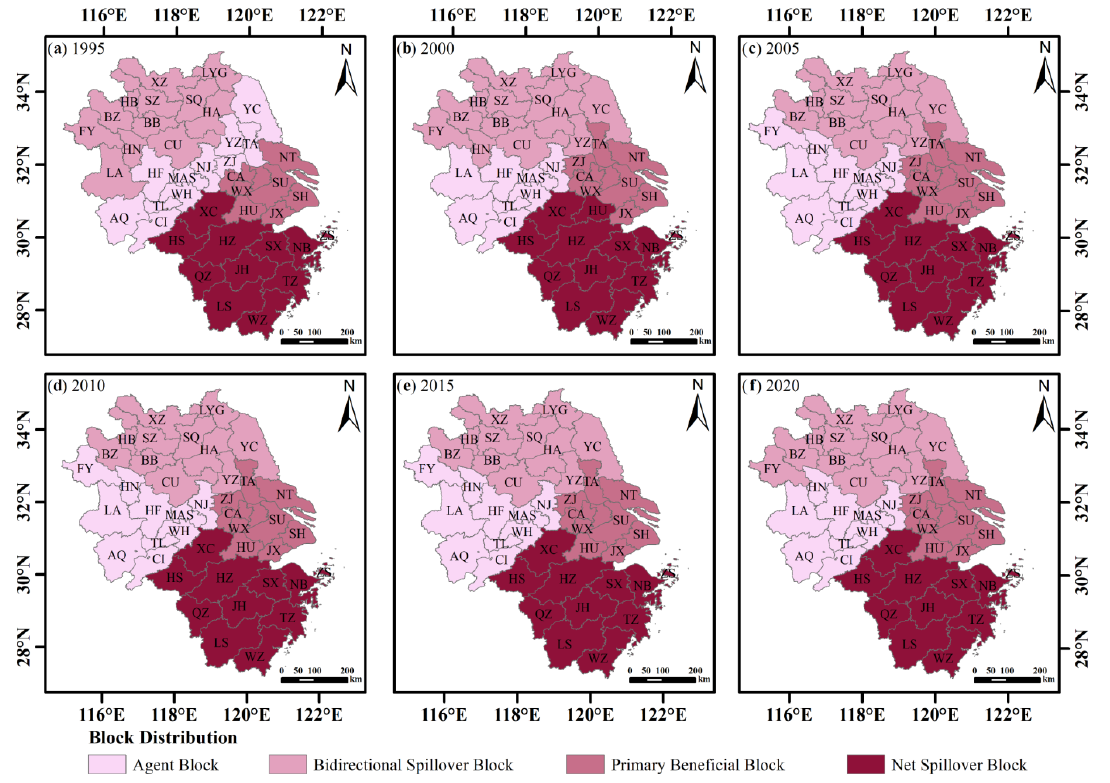
Figure 6. SCN block distribution of land pressure in the YRDR in 1995, 2000, 2005, 2010, 2015 and 2020. Table 3. The block density and image matrix of land pressure in the